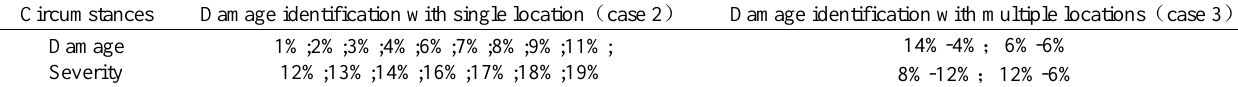
Table 12 Damage cases for inference ability of fuzzy systems